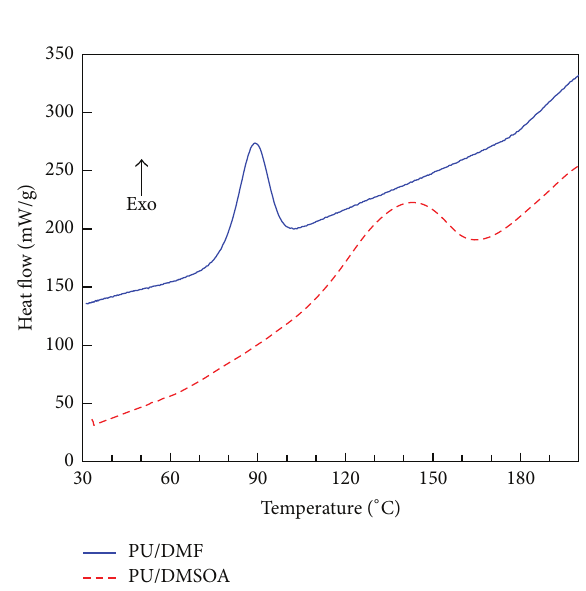
Figure 5: DSC exothermic thermograms of the PU/DMF and PU/ DMSOA